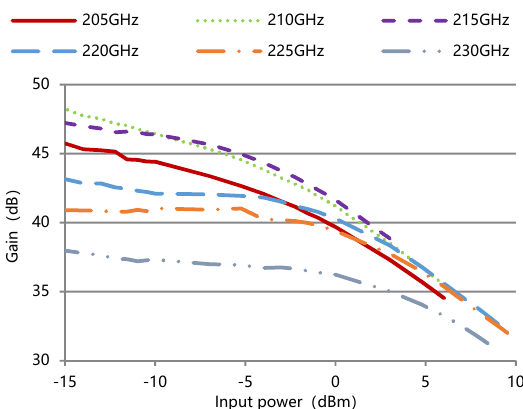
Figure 17. Measured gain against input power for the TWT at different frequencies.